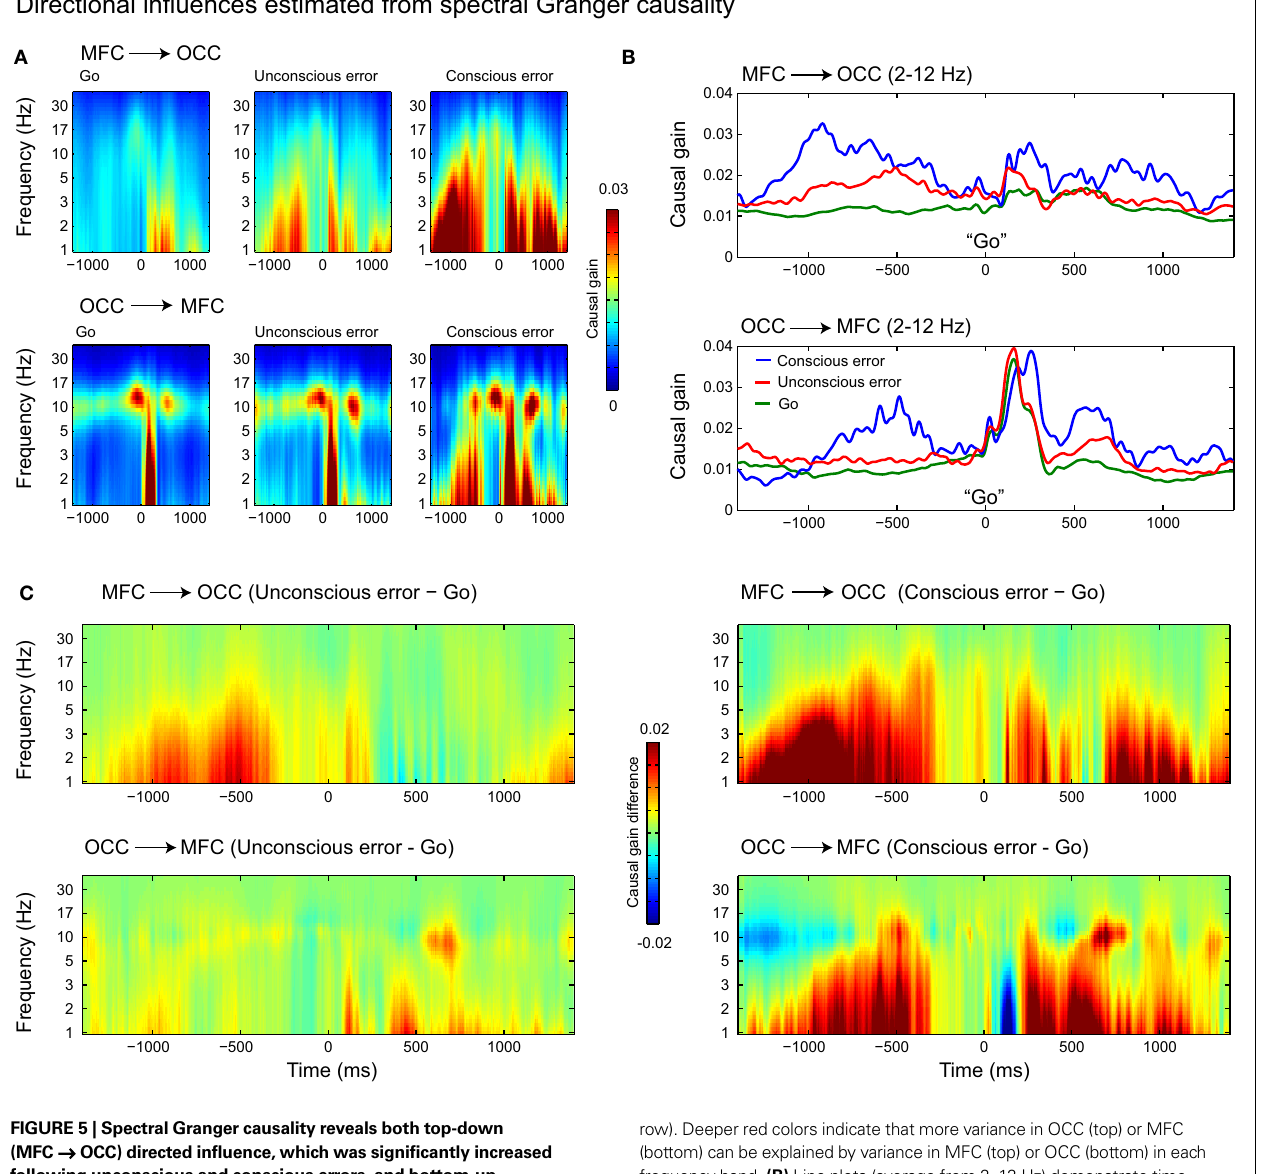
row). Deeper red colors indicate that more variance in OCC (top) or MFC (bottom) can be explained by variance in MFC (top) or OCC (bottom) in each frequency band. (B) Line plots (average from 2–12 Hz) demonstrate time courses of directed synchrony effects. (C) Difference maps between trials following unconscious errors and Go trials (left side) and between trials following conscious errors and Go trials (right side) demonstrates time- frequency regions in which condition differences were